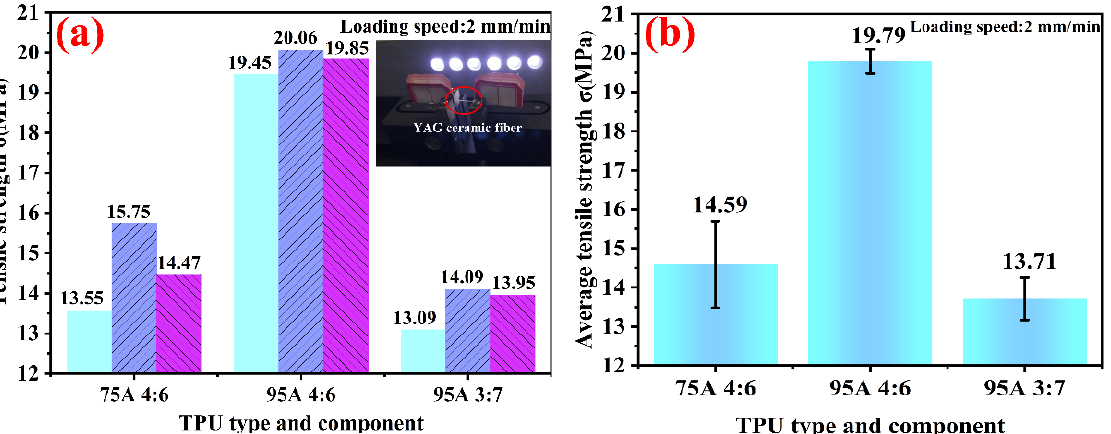
Figure 6. Tensile strength of different TPU types and components: ( a ) three tensile strength tests of different TPU types and components (TPU ‐ 75A# and ceramic powder = 4:6, TPU ‐ 95A# and ceramic powder = 4:6, TPU ‐ 95A# and ceramic powder = 3:7; inset: the test situation by the monofilament strength tester), ( b ) average tensile strength of different TPU types and components.